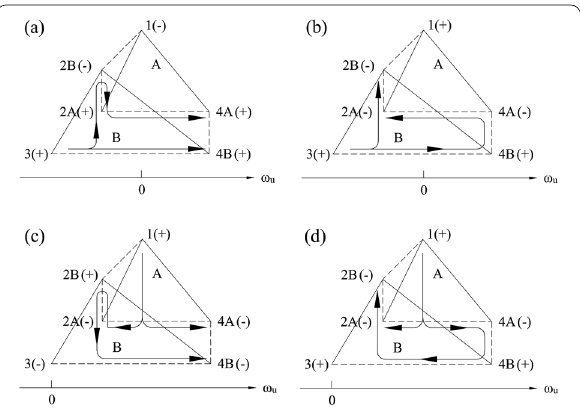
Figure 7 Torque directions and power flow of Simpson gear train: ( a ) 3‑4‑1, ( b ) 3‑2‑1, ( c ) 1‑4‑3, ( d )